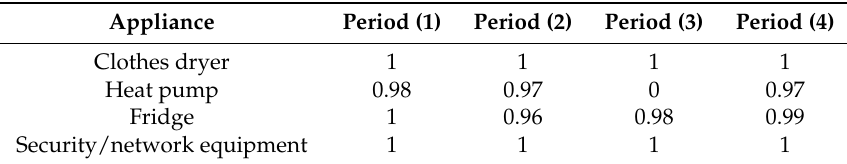
Table 2. F-score values from four periods for the four appliances.